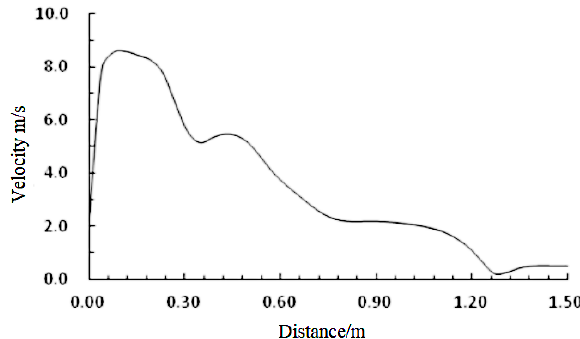
Figure 22. Velocity change at the hull